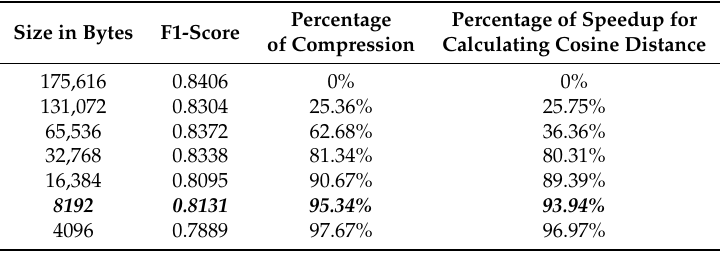
Table 2. Study about the performance of compressed features. The bold and italic items denote the